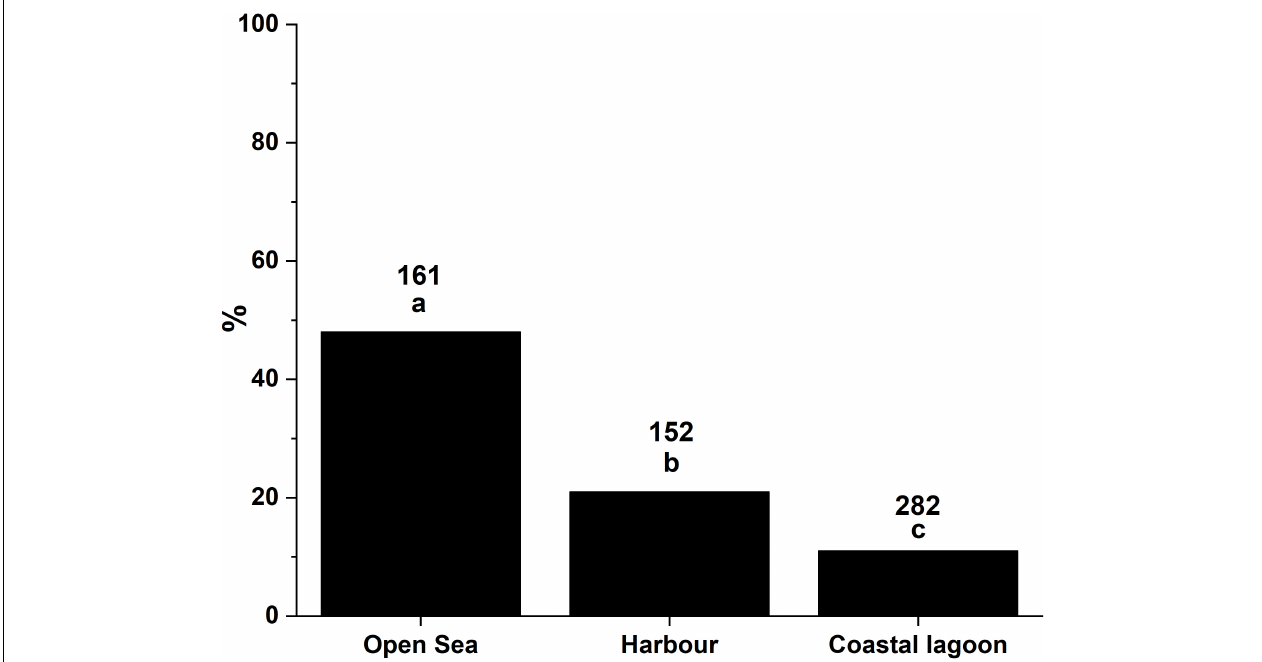
FIGURE 7 | Percentages of infection with Haplosporidium pinnae corresponding to different ecosystems. Different letters above bars denote significant differences between environments. The numbers above bars correspond to the number of fan mussels diagnosed in each